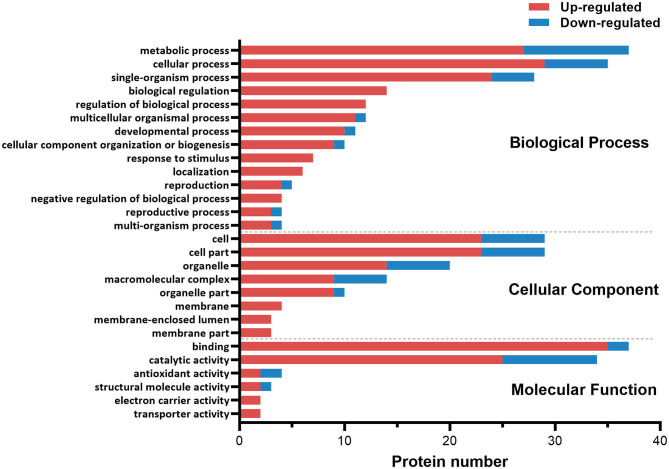
Gene ontology (GO) classification diagram of differentially expressed proteins in the ovary of ESA and ESI crabs. Red and blue represent upregulated and downregulated proteins after ESA, respectively.